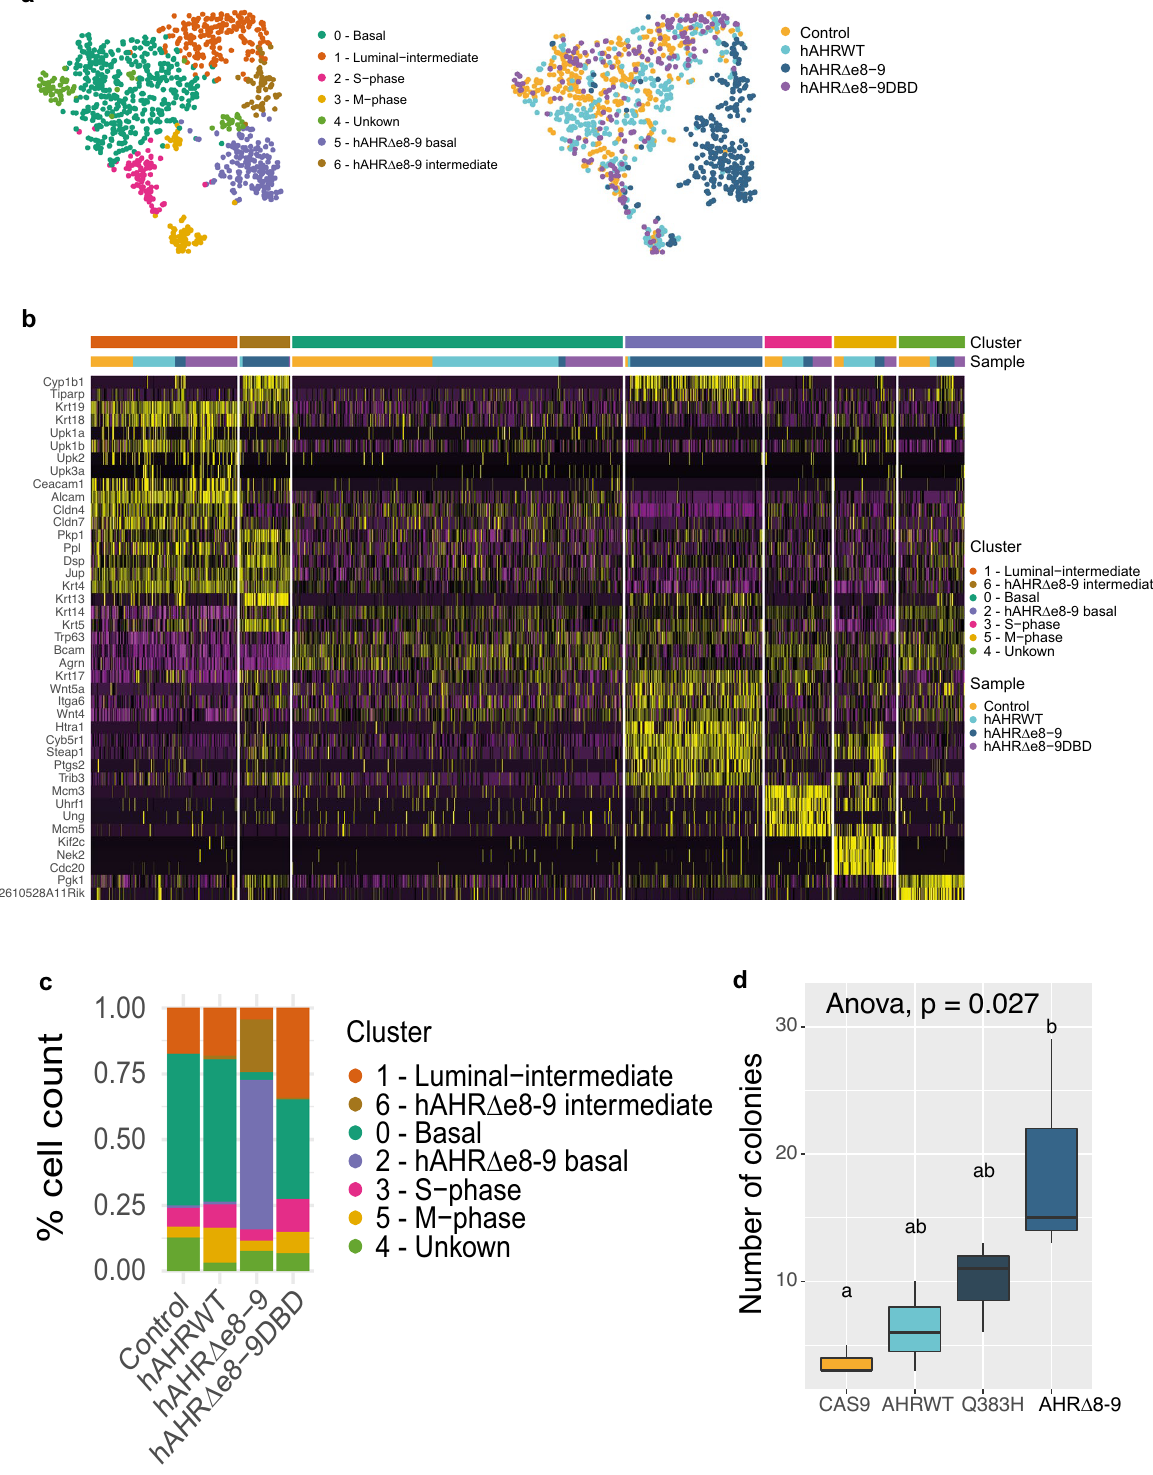
Figure 4. Transformed phenotype of hAHR Δe8-9 mutant. ( a ) tSNE plot of single cell transcriptomics depicting clusters of the transgenic mouse bladder organoids cells. Plot is coloured for detected clusters and for the different transgenic mouse bladder organoid lines. ( b ) Heatmap depicting expression of selected markers, which are identified by expression analysis, representative for the different identified clusters. ( c ) Contribution of percentage of cells to the different clusters for each transgenic mouse bladder organoid line. ( d ) Soft agar assay of mouse bladder organoids expressing hAHR mutants. Results are presented as the mean ± SD of triplicate